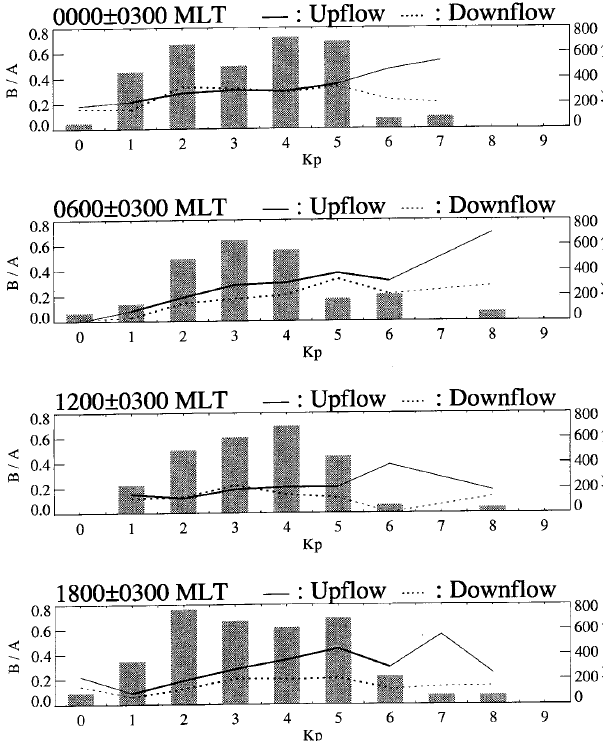
Fig. 8. Schematic diagram to show how the ion velocity components perpendicular to and parallel to the magnetic field line contribute to the